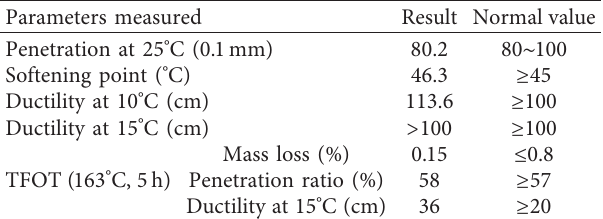
Table 1: Basic properties of 90# Donghai asphalt.